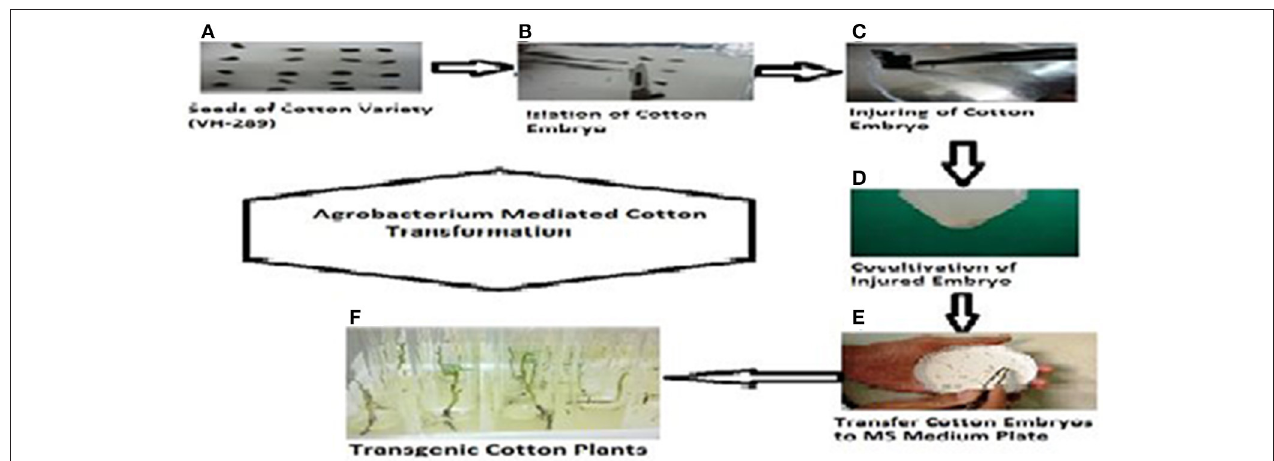
FIGURE 3 | Complete protocol of Agrobacterium mediated transformation in cotton. (A) Germinated Seeds of VH-289, (B) embryo isolation, (C) injuring of cotton embryos with sharp blade, (D) co-culturing of injured embryos in MS broth with gene of interest (Cry2A and GTG), (E) cotton embryos are shifted to selection free MS medium plate, (F) cotton embryos shifted to test tubes with selection drug (kanamycin) for screening.